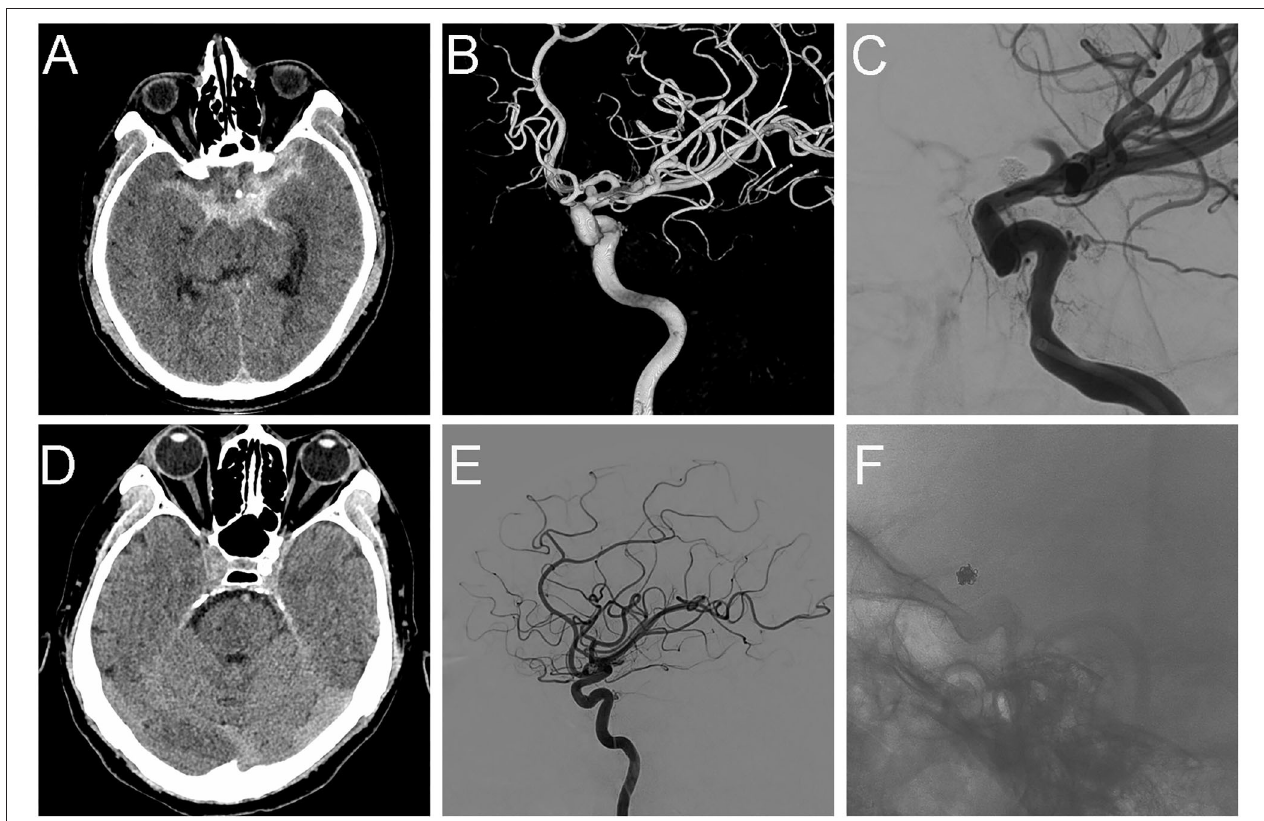
FIGURE 1 | Typical case images. (A) CT scan showing SAH in suprasellar cistern before operation. (B) Preoperative DSA showing BBA at C7 segment of the left ICA. (C) Intraoperative DSA showing complete occlusion of the BBA using PED + coils. (D) CT scan at 1-month follow-up. (E,F) DSA and Xper-CT at 6 months